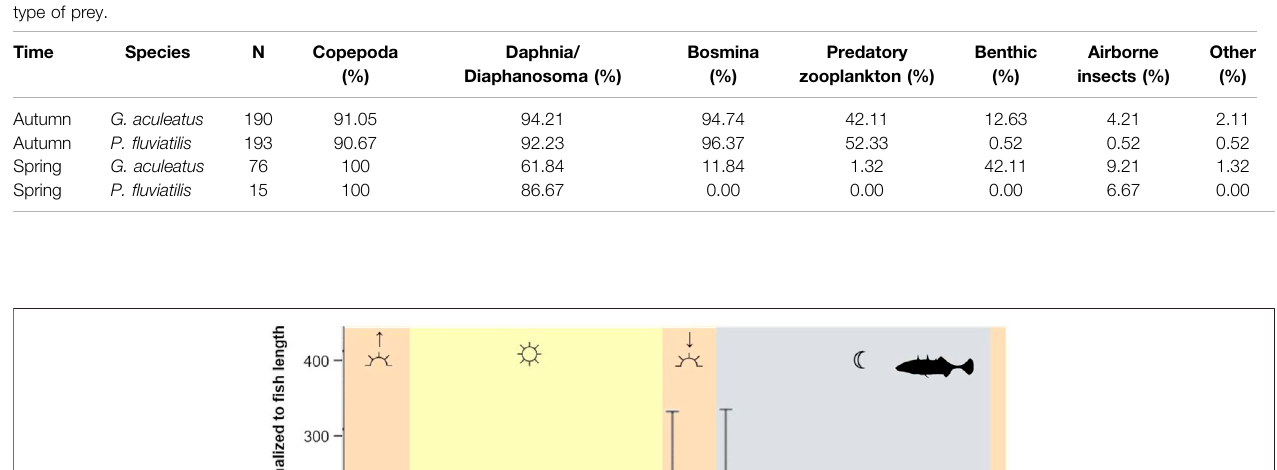
Frontiers in Environmental Science |